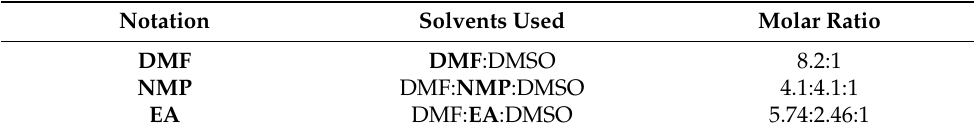
Table 1. The solvent ratio used in the KFAMA precursor